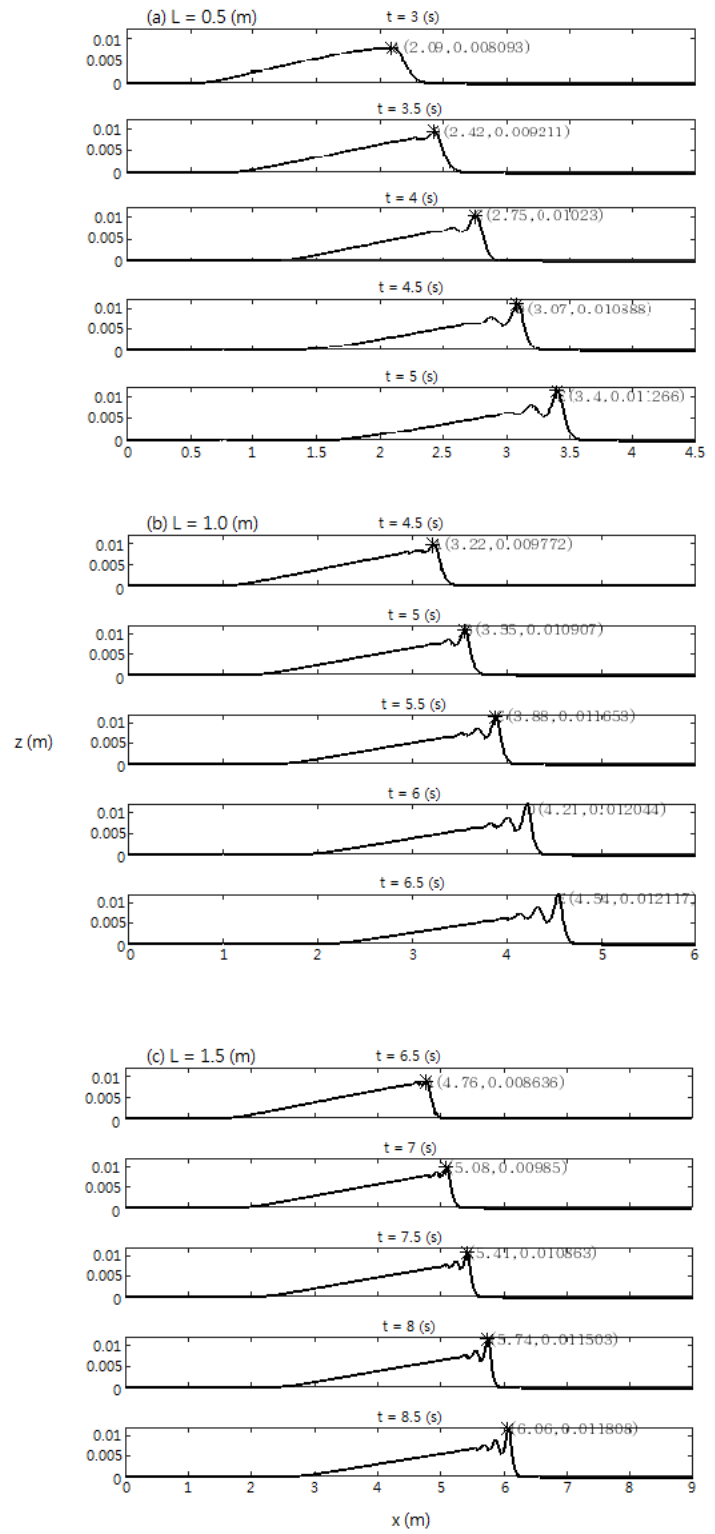
Figure 6. Evolution of leading elevation waves due to upward bottom motion with different length of movable segment, L , on a constant depth, h 0 . ( a ) L = 0.5 m; ( b ) L = 1.0 m; ( c ) L = 1.5 m. Peaks are denoted by asterisks and values in the parentheses indicate (time,displacement) at each peak. In all cases, h 0 = 0.03 m, a = 0.02 cm, b = 0.5 s, and θ =